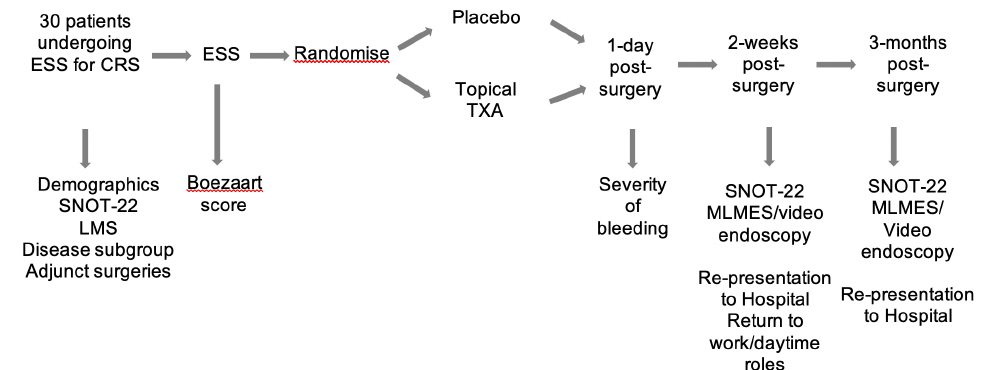
Figure 1. Summary of the study protocol. ESS = Endoscopic sinus surgery: CRS: Chronic RhinoSinusitis: SNOT-22 = 22-item Sinonasal outcome tool; LMS = Lund-Mackay score; MLMES = Modified Lund-Mackay Post-operative endoscopic